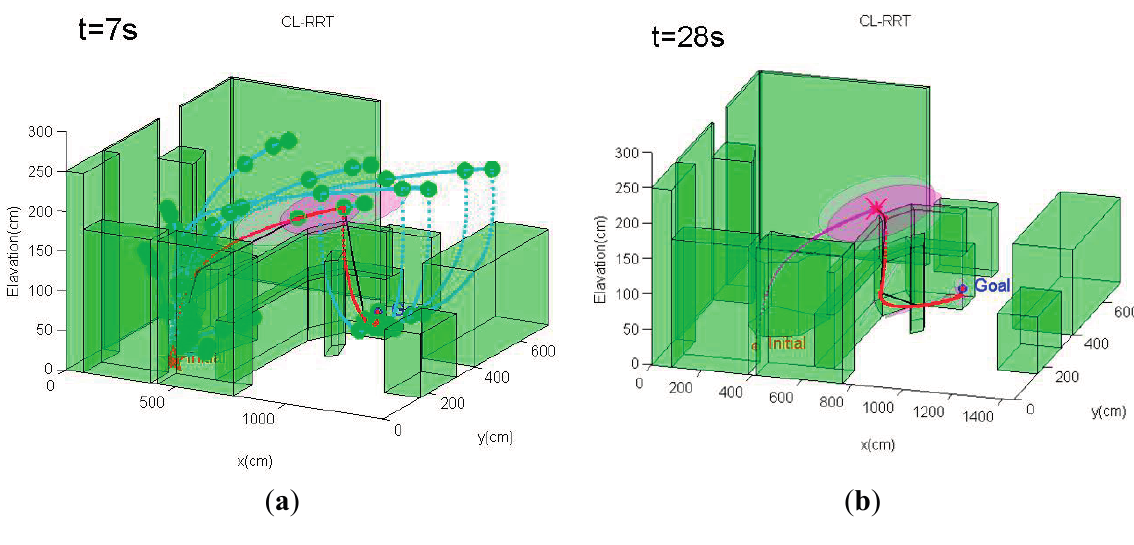
Figure 12. Example results of trajectory generated by the conventional CL-RRT for a quadrotor MAV navigating in simulation Scenario 1. The red cross in ( b ) denotes the position where the MAV’s state estimation fails since the position uncertainty have exceeded the threshold. ( a ) t = 7 s; ( b ) t = 28